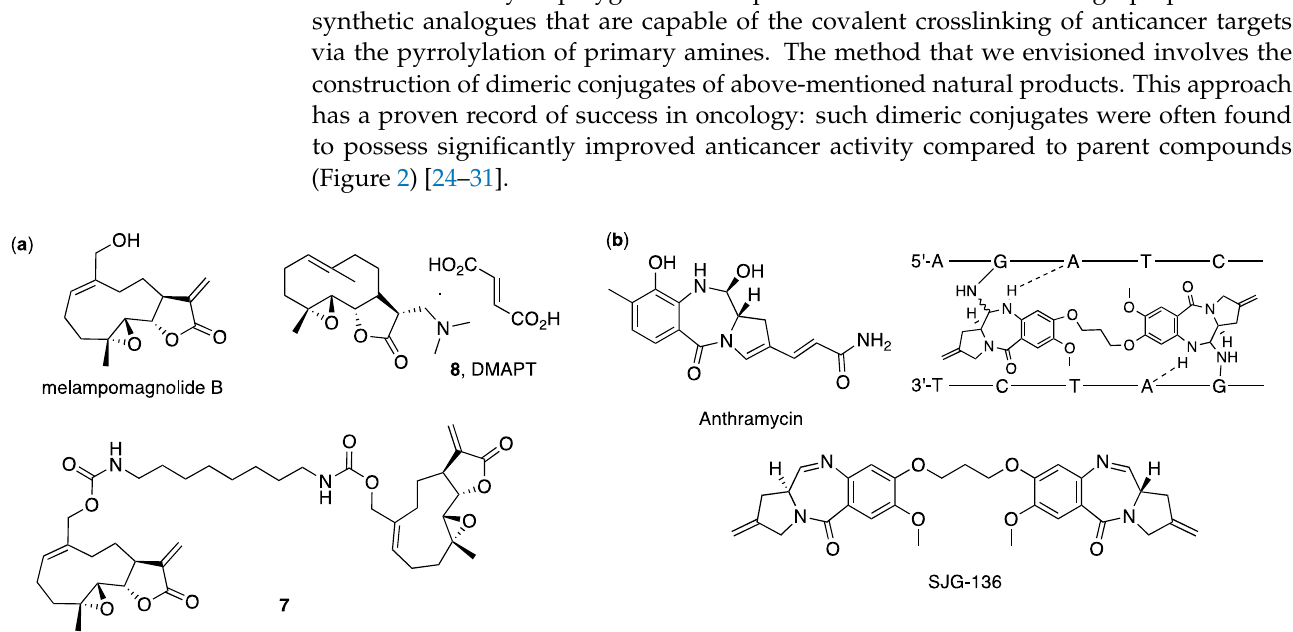
Figure 2. Dimeric anticancer conjugates of natural products: ( a ) Melampomagnolide B, its monomeric ( 8 ) and dimeric ( 7 ) derivatives; ( b ) Anthramycin, dimer SJG-136 and schematic representation of interstrand cross-link formation through DNA binding.